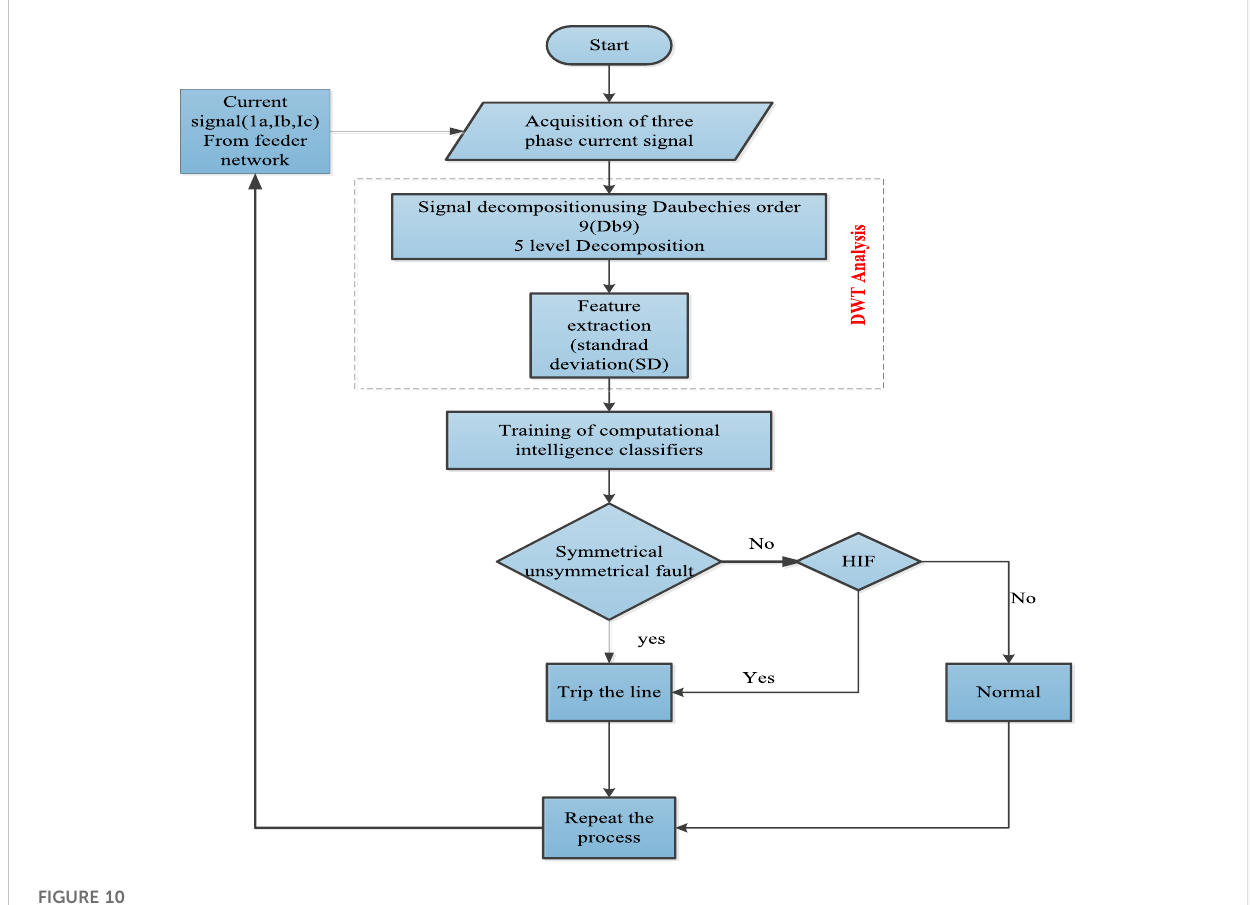
FIGURE 10 Schematic representation of the fault tolerant classi fi